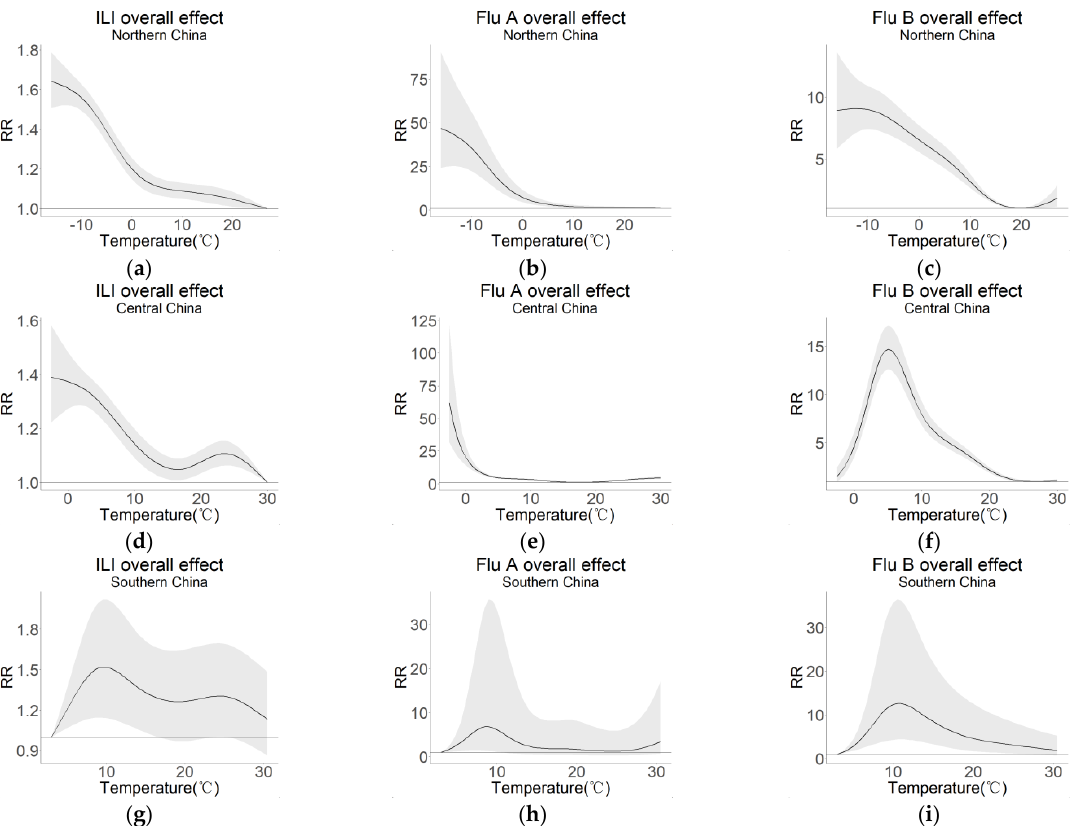
Figure 4. Overall effects between ILI, Flu A, and Flu B and temperature in different regions and 95% confidence intervals. ( a ) ILI overall effect in northern China; ( b ) Flu A overall effect in northern China; ( c ) Flu B overall effect in northern China; ( d ) ILI overall effect in central China; ( e ) Flu A overall effect in central China; ( f ) Flu B overall effect in central China; ( g ) ILI overall effect in southern China; ( h ) Flu A overall effect in southern China; ( i ) Flu B overall effect in southern China. The shaded area represents the 95% confidence interval. Abbreviations: ILI, influenza-like illness; Flu A, influenza A; Flu B, influenza B; RR, relative risk.